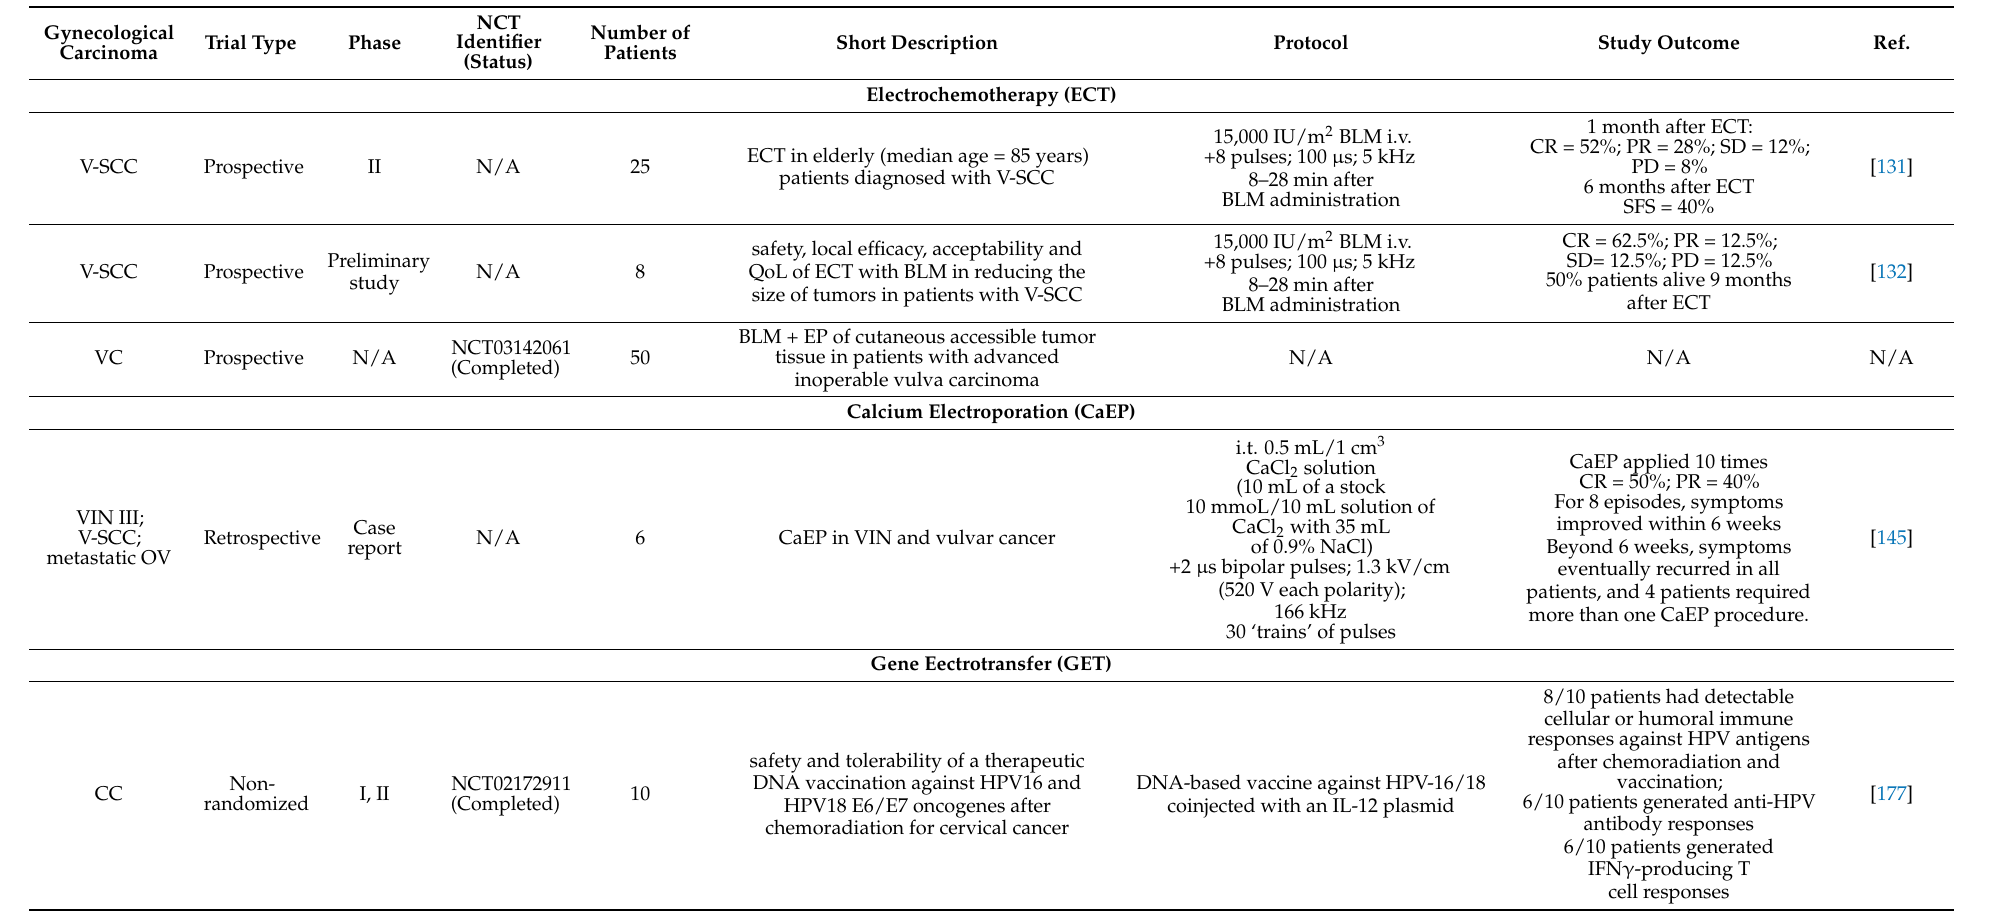
Table 2. Clinical trials, preliminary studies, and case reports focusing on the use of EP-based therapies in gynecological carcinomas